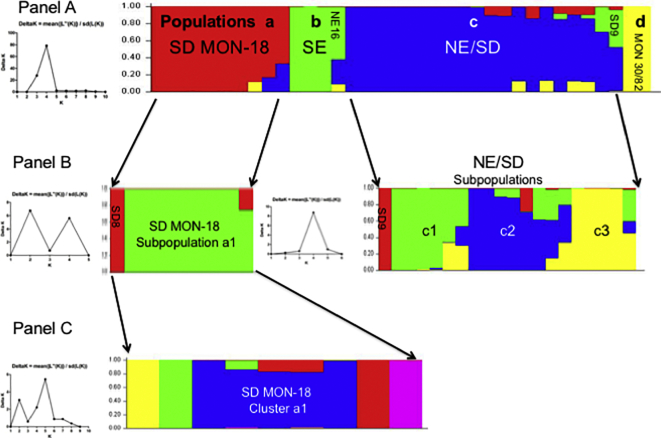
Population analysis of the 36 east African Leishmania donovani strains as determined by STRUCTURE (Pritchard et al., 2000) based on AFLP using six selective primers. A single vertical bar represents each strain with the different colors indicating to the fraction of genotype attributed by each population (Q). A single colour indicates that a strain belongs to only one genetic group. Population parameters were estimated by 10 Markov Chain Monte Carlo iterations after a burn-in of 100,000 simulations. Panel A. At K = 4 the strains group into four distinct populations which was confirmed by ∆K analysis, plot on left, using Structure Harvester (Earl and Vonholdt, 2012): a) SD MON-18 - all 10 Sudanese MON-18 strains; b) SE - the southern Ethiopian strains plus one atypical northern Ethiopian (NE) HIV/VL bone marrow strain (NE16); c) NE/SD - 17/18 NE strains and three of the SD strains: PKDL strain SD9 (MON-267), SD1 and SD2; and d) MON30/82 –PKDL strains SD3 and SD15 with zymodemes MON-82 and MON-30, respectively. Panel B. Further analysis of SD MON-18 and NE/SD by STRUCTURE identified additional subgroups. Subpopulation a1 contains all of the SD MON-18 strains except SD8, while the NE/SD population was divided into four subpopulations: c1 - NE1, NE4, NE6 - NE8 and SD2; c2 - NE2, NE3, NE5, NE9, NE10, NE17, NE18 and SD1; c3 - NE11 - NE15; and a fourth group containing the PKDL isolate SD9 (zymodeme MON-267). Panel C. Further analysis of SD MON-18 subpopulation a1. Cluster a1 contains SD6 SD7, SD10, SD11 and SD12.